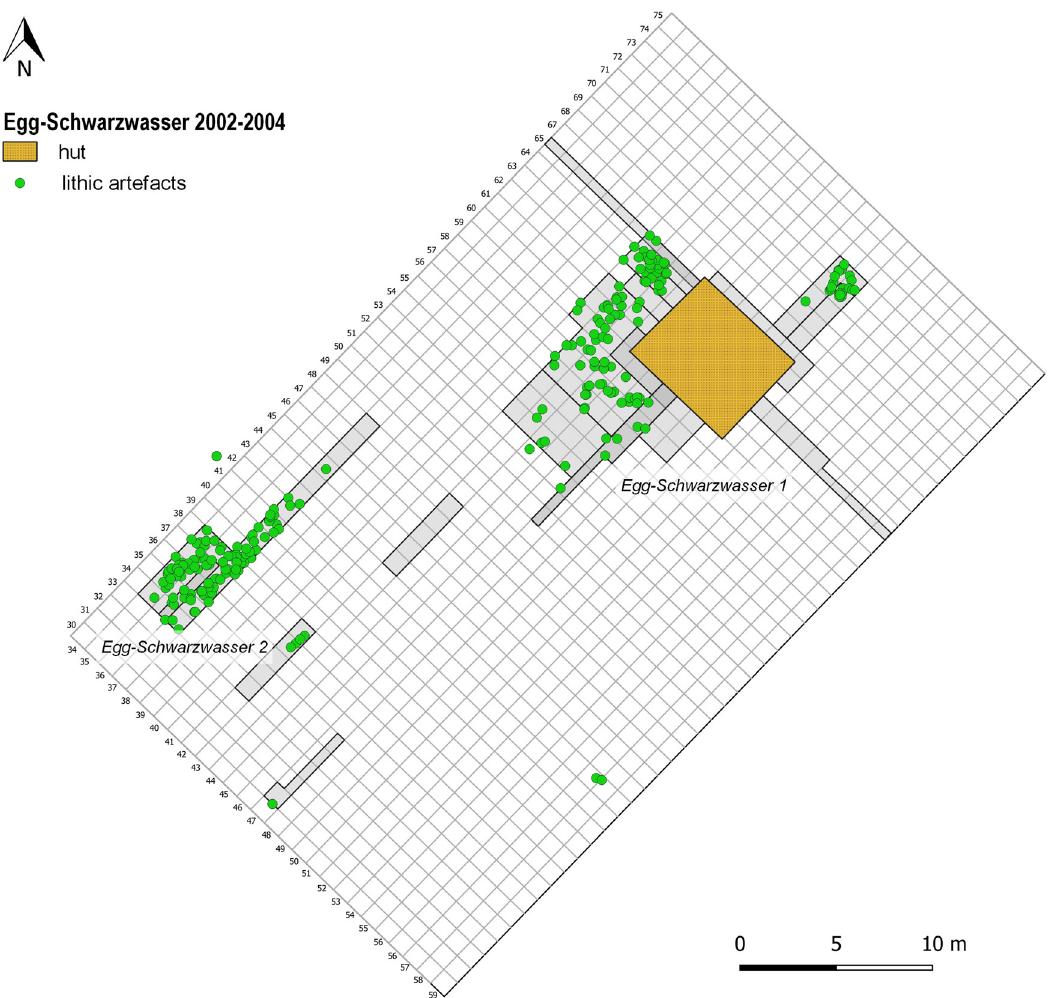
Figure 4: Artefact clusters Egg - Schwarzwasser 1 and 2 ( Posch, 2022, Abb. 8.7 )